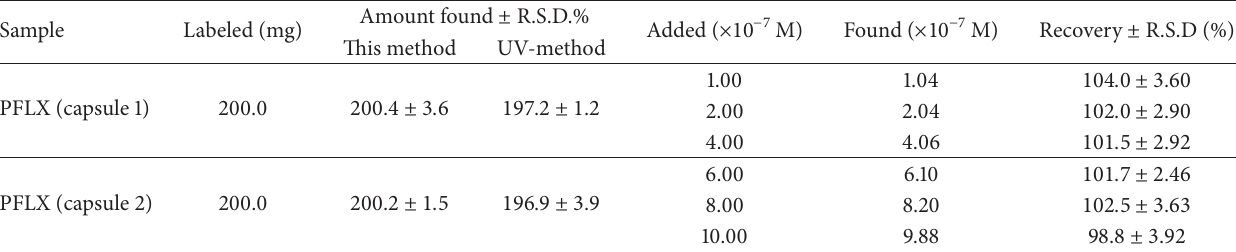
Table 3: Results for the determination of PFLX in capsules ( 𝑛 = 5 ).